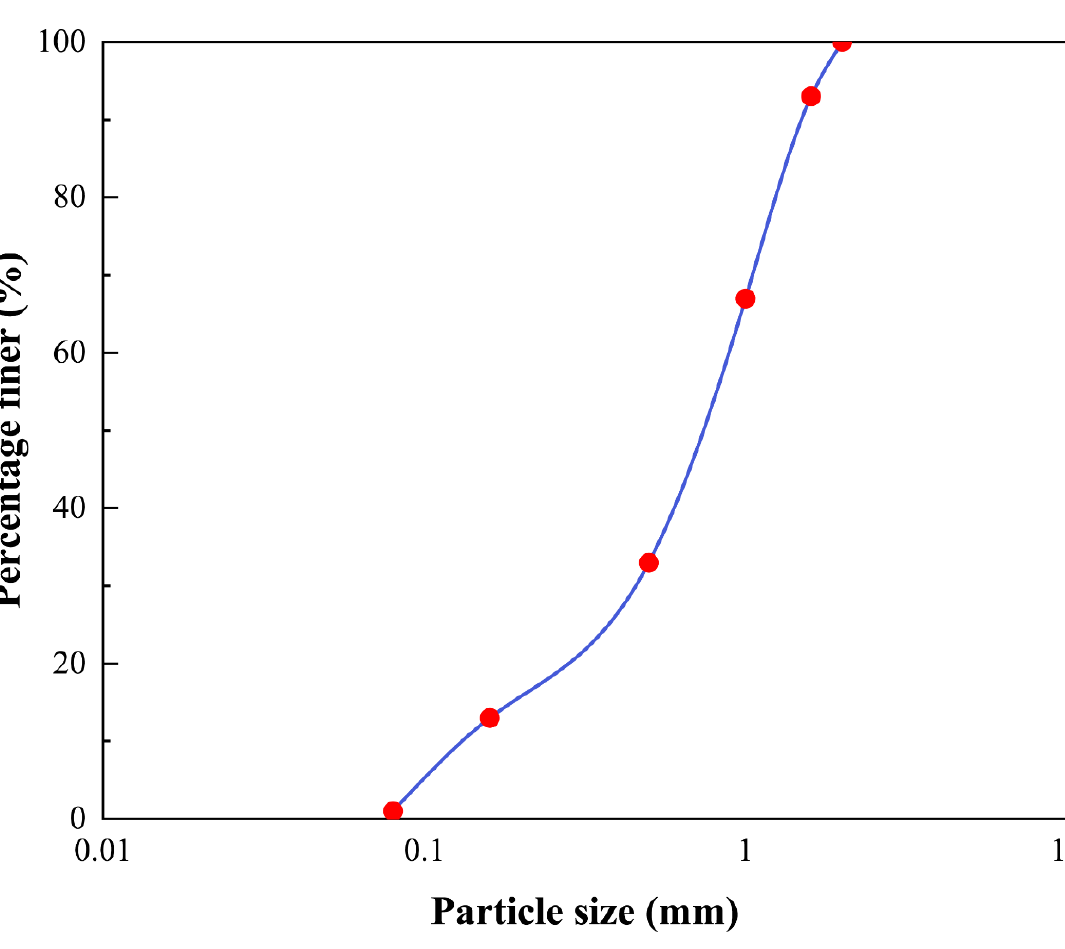
Figure 1. Particle size distribution of the sand.